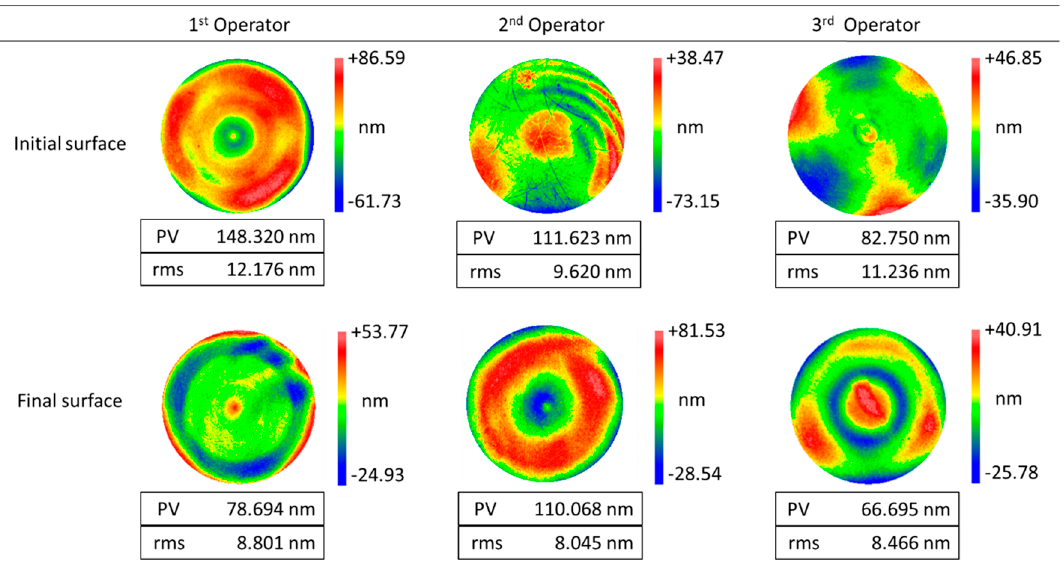
Figure 11. Profile of the initial and final surface form errors in test B.